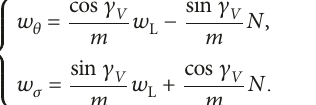
Figure 3: ENU coordinate frame and LOS coordinate